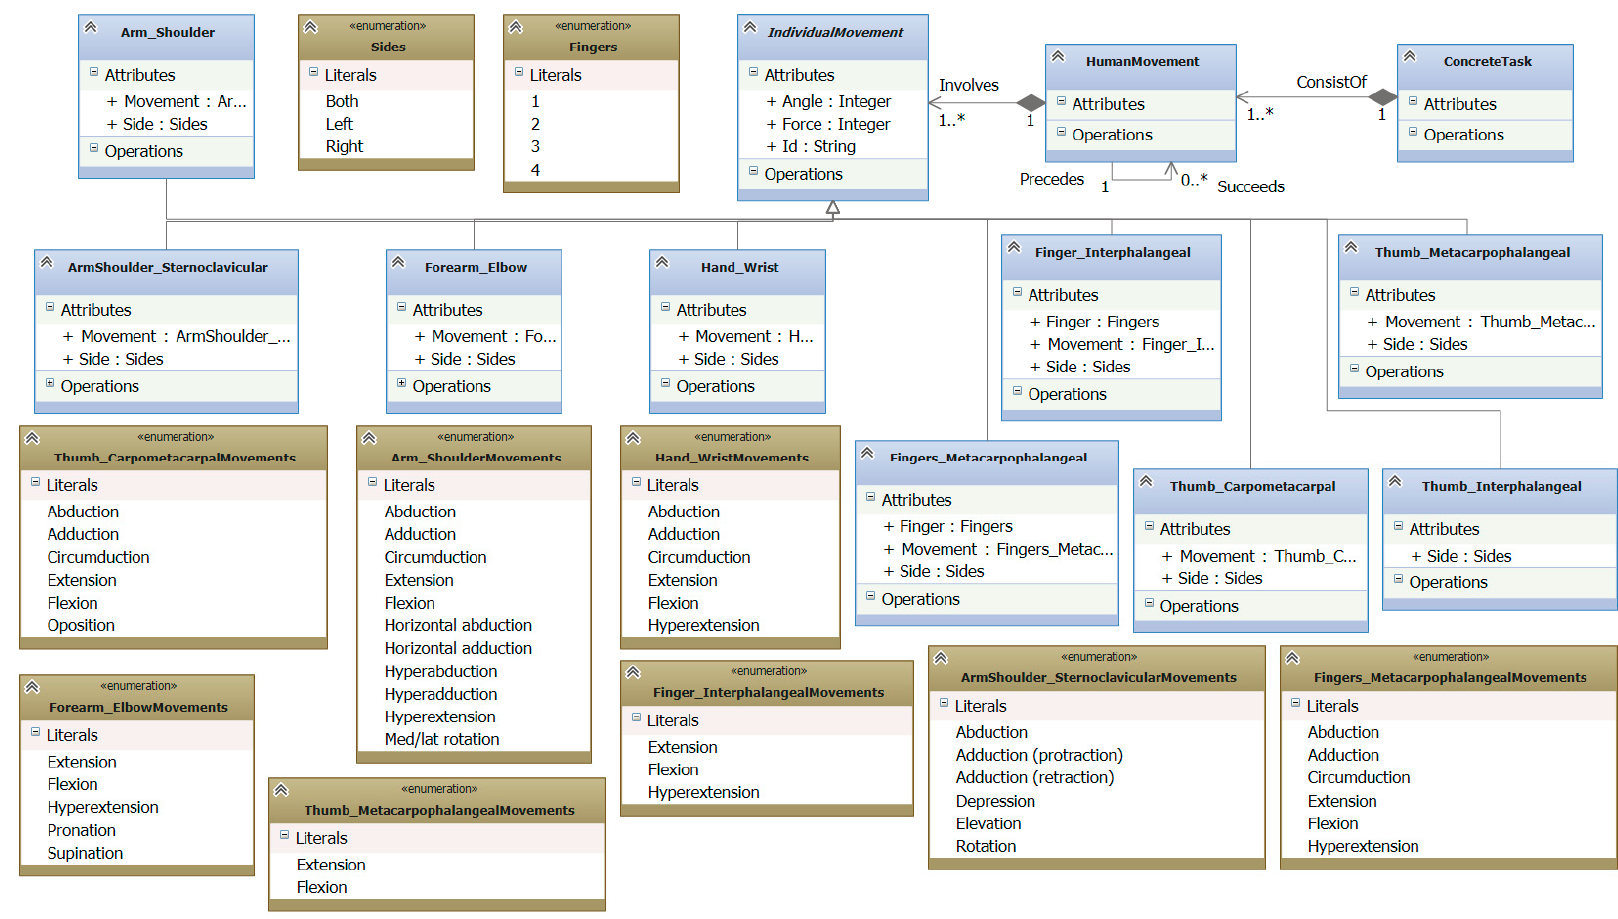
Figure 6. An excerpt of the bio-inspired presentation